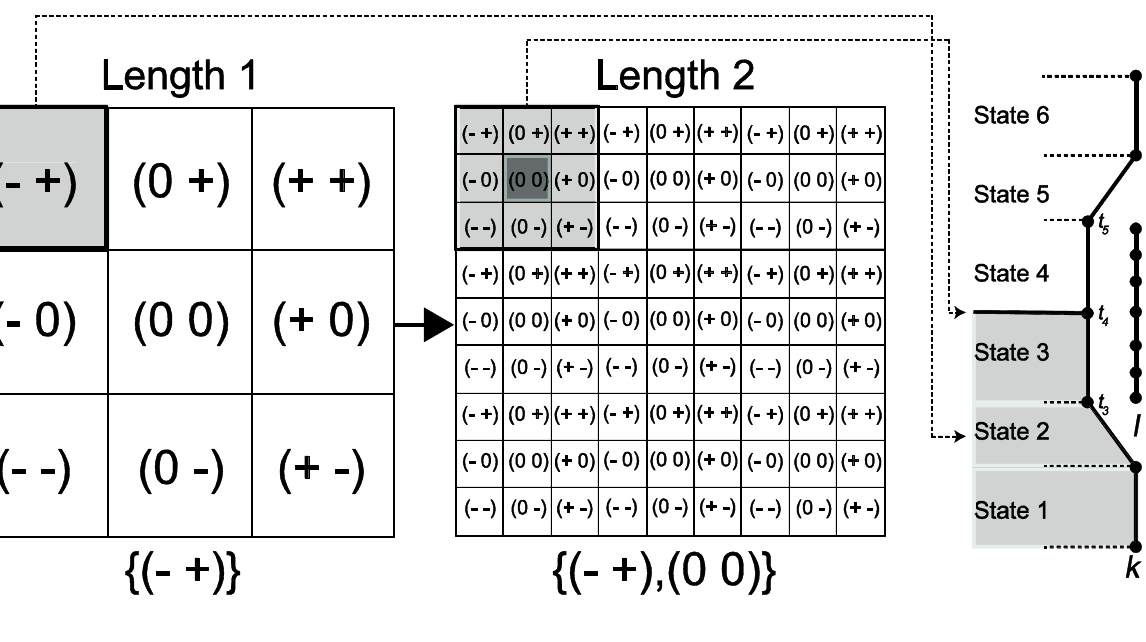
Figure 2. SESIs of lengths 1 and